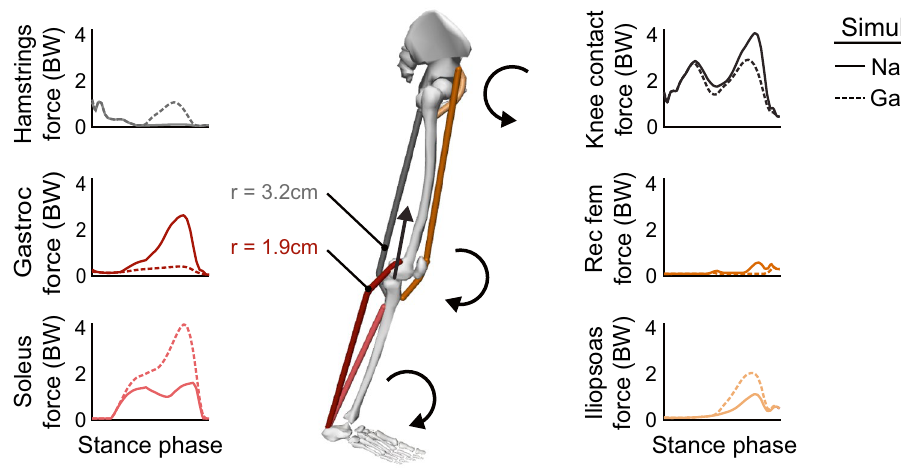
Figure 3. Simulation of a gastrocnemius avoidance coordination pattern. Identical joint kinetics were simulated (n = 1) with a natural (Eq. 1) and a gastrocnemius (gastroc) avoidance (Eq. 2) static optimization objective function. During late stance, the muscles generate ankle plantarflexion, knee flexion, and hip flexion moments. The gastrocnemius avoidance coordination pattern requires increased soleus and hamstrings force to compensate for the ankle and knee moments normally generated by the gastrocnemius. The larger knee flexion moment arm (r) of the hamstrings compared to the gastrocnemius allows the hamstrings to generate the same moment with less force than the gastrocnemius, reducing knee contact force. A weighted average of the moment arms (hamstrings: biceps femoris long head and short head, semitendinosus, semimembranosus; gastrocnemius: medial and lateral heads) was computed at 75% of the stance phase, weighted by each muscle’s optimal force in the musculoskeletal model 36